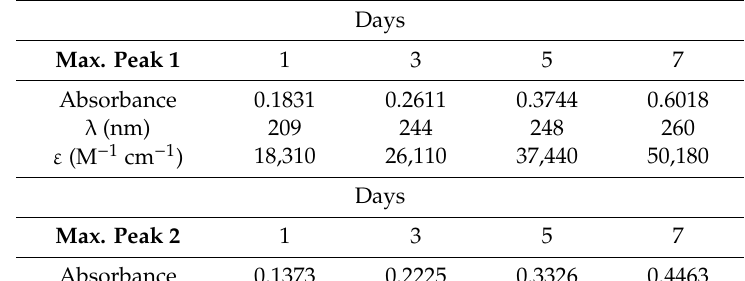
Table 1. UV-vis spectral data for G1 10 − 5 M in ethanol at 20 °C.